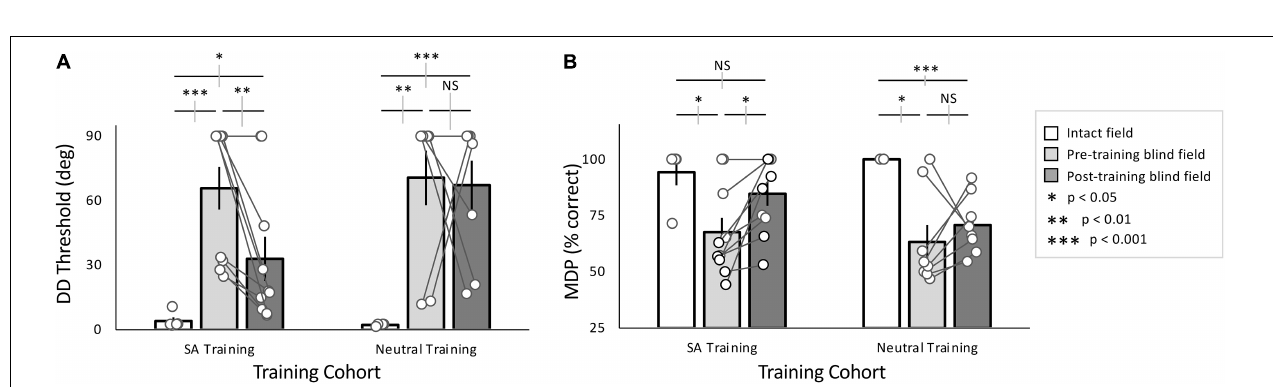
Frontiers in Neuroscience |